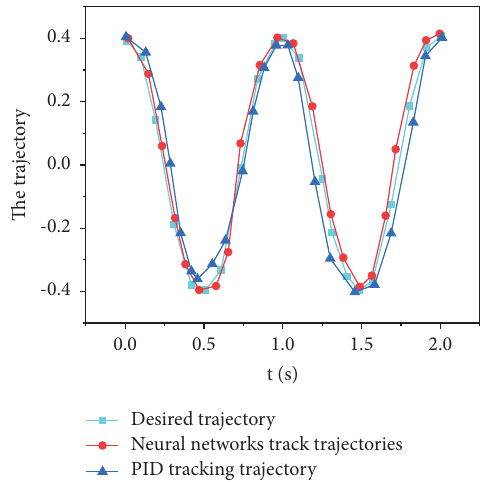
Figure 3: Movement trajectory of robotic arm 3 (no external interference).